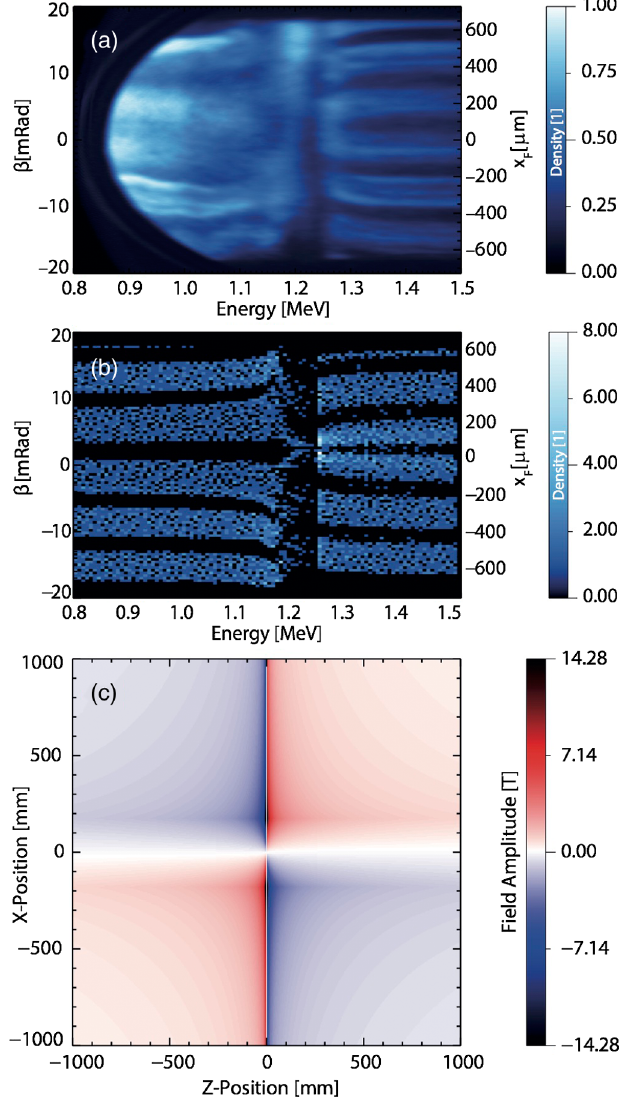
FIG. 11. Proton deflectogram: (a) experiment, (b) model cal- culation obtained for a ps-pulse irradiation of a 30 nm plastic foil in a longitudinal probing geometry, (c) calculated magnetic field accounting for the